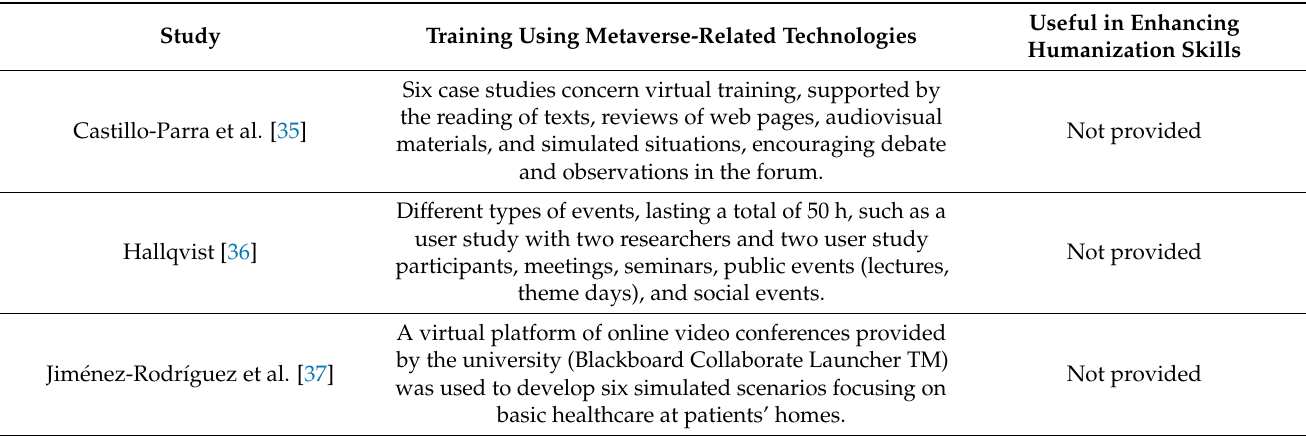
Table 3. Primary outcomes ( n = 3).